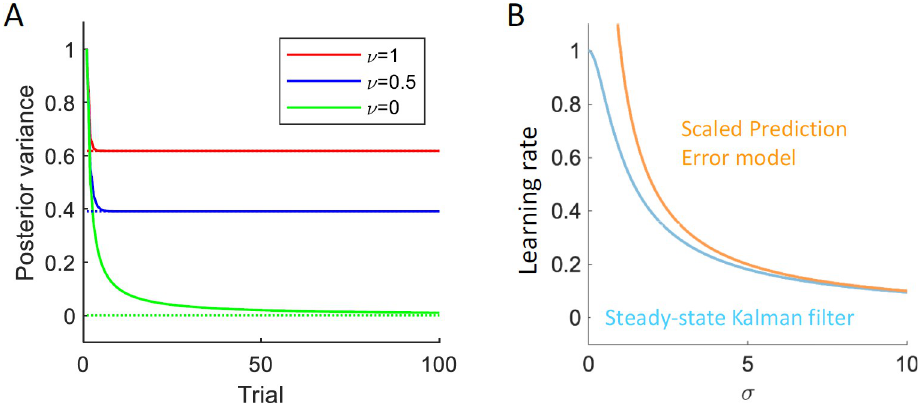
Fig 5. Variables of the Kalman filter and its approximations. A Posterior variance in the Kalman filter (solid, Eq 19) and the steady–state Kalman filter (dotted, Eq 20), as a function the number of observations. Different colours correspond to different levels of process noise, and the values are plotted for the standard deviation of the observation noise of σ = 1. B The learning rate of the steady–state Kalman filter k 1 (blue, Eq 21) and the approximation k (orange) which corresponds to the effective learning rate in the SPE model. We show the learning rates as a function of the observation noise σ for process noise of ν = 1.